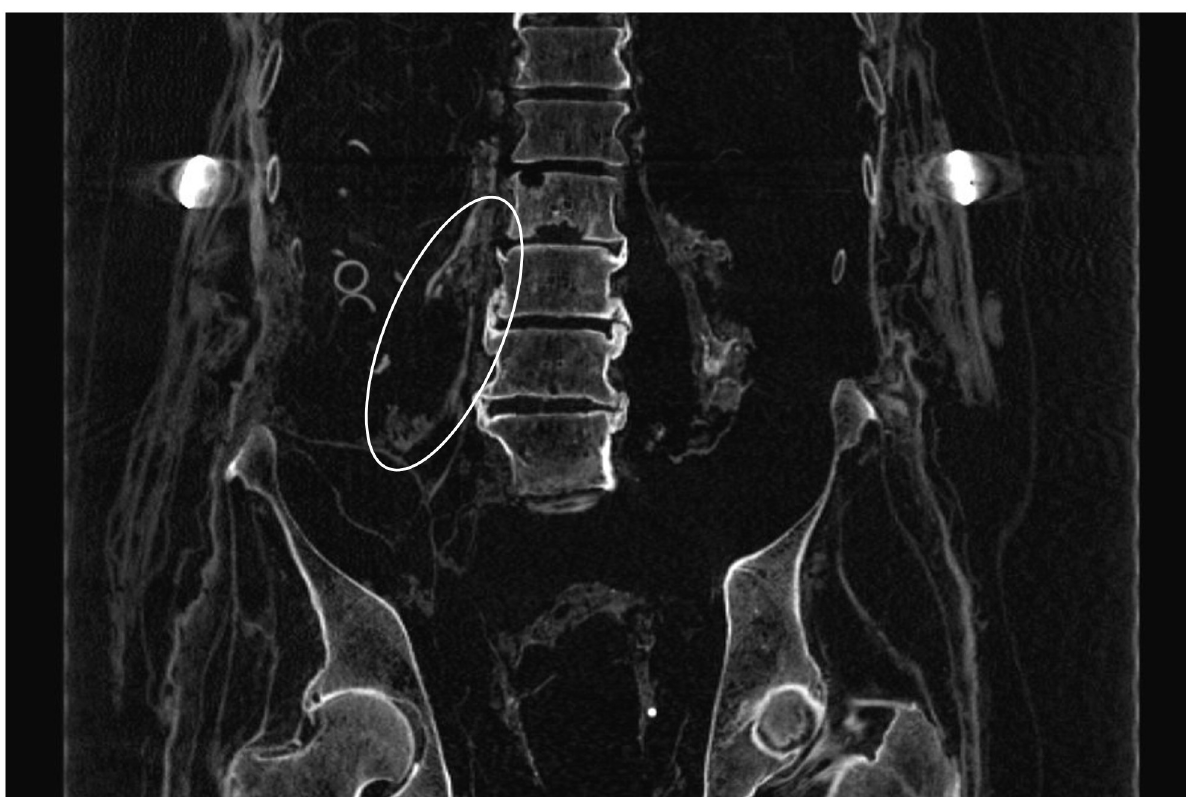
Fig 7. Coronary plain section of the CT scans with a further aspect of the cystic lesion at the retroperitoneal space (circle).